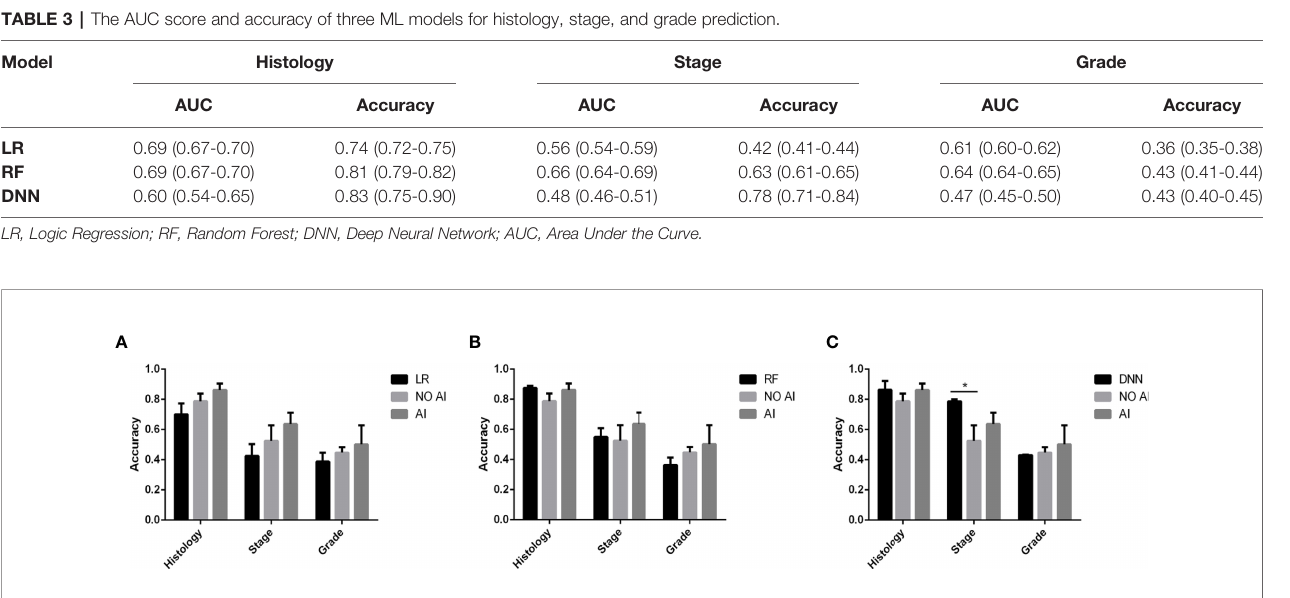
FIGURE 2 | The accuracy comparison between doctors with and without AI assistance and AI in predicting stage and grade. (A – C) shows the different AI assistance models. * Indicates P <